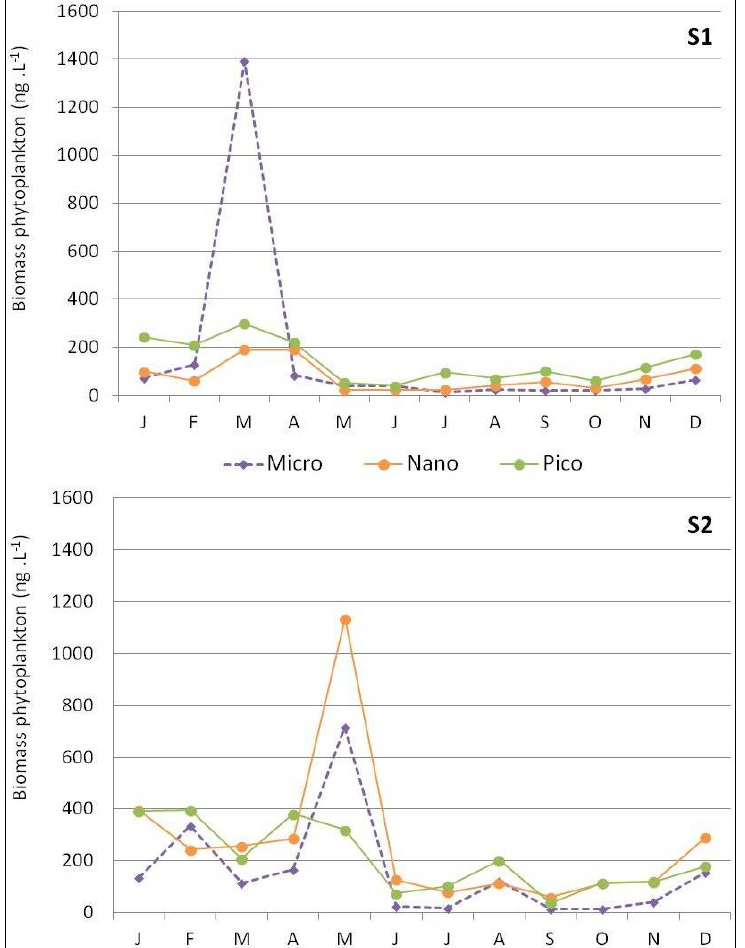
Figure 4. Spatio-temporal variability of biomass size classes for micro-, nano-, and picophytoplankton according to the equation of Vidussi et al . [40] at S1 and S2